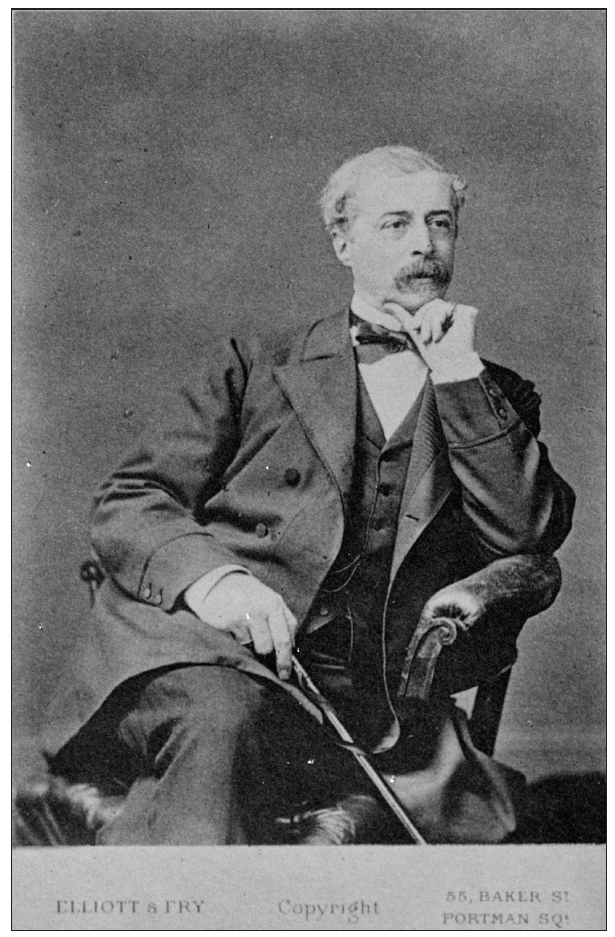
Fig. 1 : Sir Richard Wallace, Carte de visite photograph by Elliott & Fry, c. late August 1871–October 1872, Wallace Collection Picture Library. © The Trustees of the Wallace Collection,